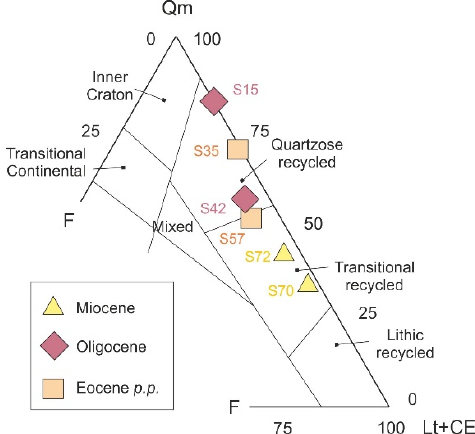
Figure 5. Qm/F/Lt + CE ternary diagram [85] indicating a discrimination of the sandstones’ provenance. Qm: monocrystalline quartz; F: feldspars (plagioclase and K-feldspars); Lt + CE: lithic fragments including carbonate extrabasinal clasts.